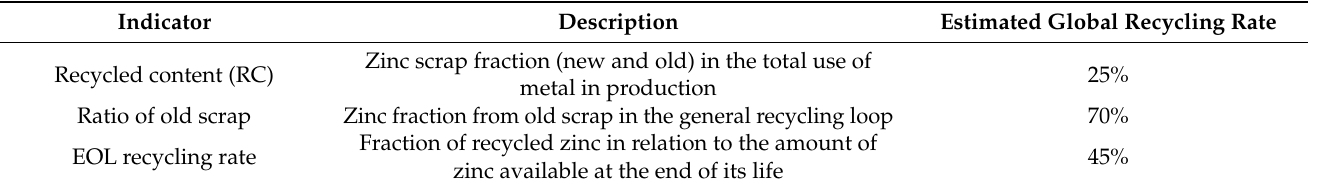
Table 9. Recycling process indicators, worked out based on [71].